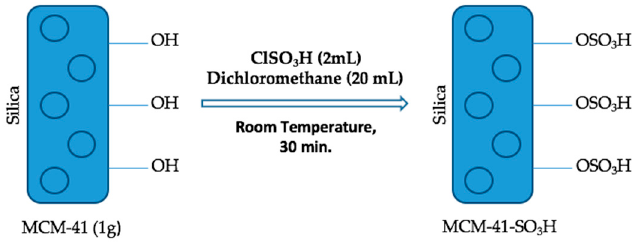
Figure 8. Preparation of SO 3 H-MCM-41. Figure 8 . Preparation of SO 3 H- MCM-41. Figure 8 . Preparation of SO 3 H- MCM-41.